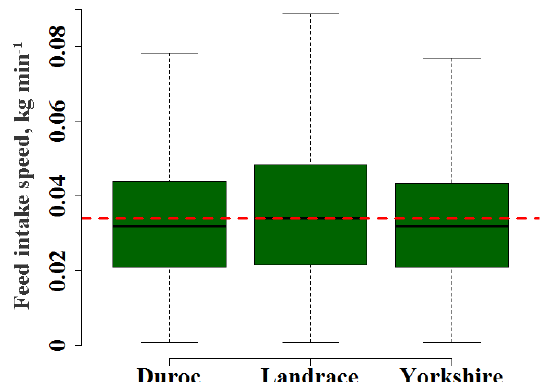
Figure A3. Feed intake speed for the three breeds. The x axis rep- resents the breed and the y axis represents the feed intake speed. The red dotted line shows the median feed intake speed value of